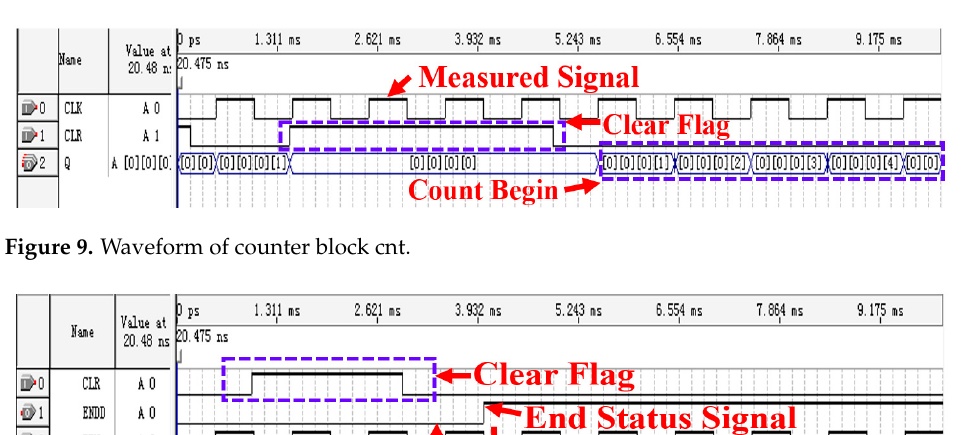
Figure 8. Waveform of top hierarchy module.